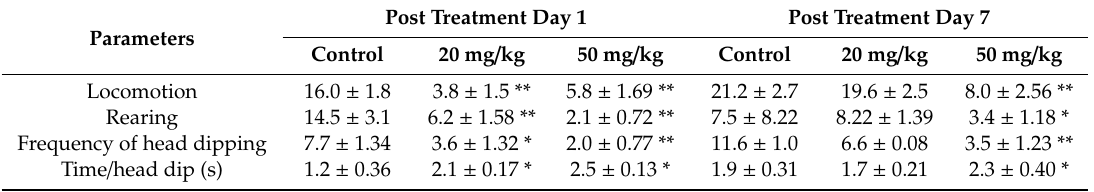
Table 1. E ff ects of Judo 40 and corn oil (control) on exploratory behavioral parameters of male